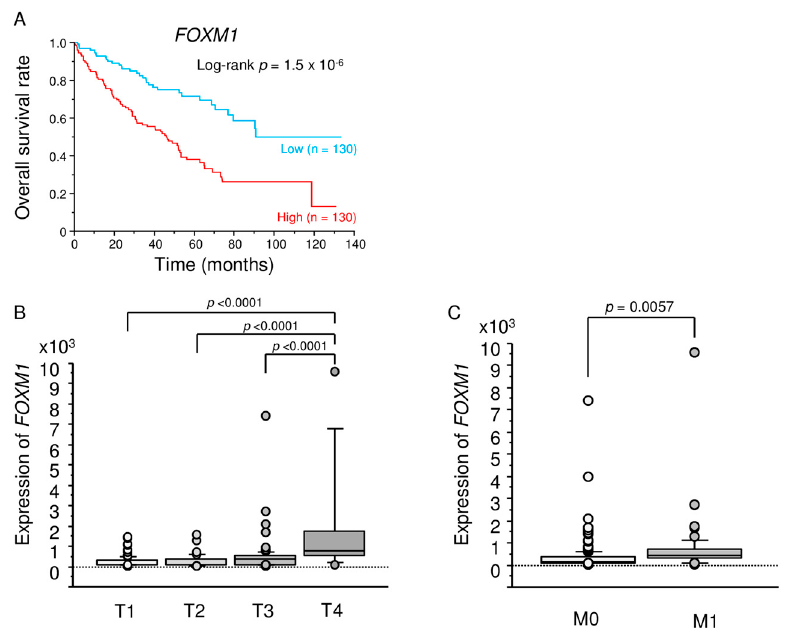
Figure 5. TCGA database analysis of FOXM1 . ( A ) Kaplan-Meier survival curves for overall survival rates based on FOXM1 expression in RCC ( p = 1.5 × 10 − 6 ) and ( B , C ) The relationships between FOXM1 expression and tumor stage and metastasis in ccRCC.